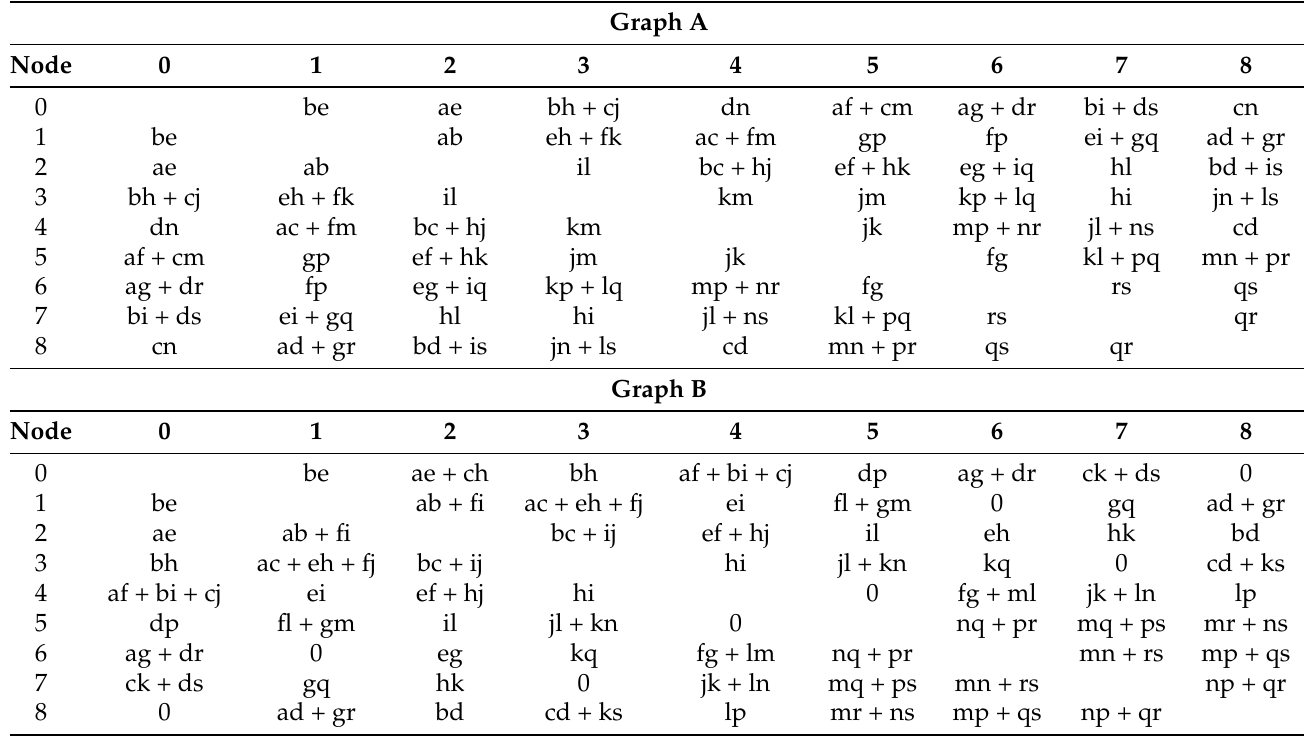
Table 1. Minimal length path consisting of two edges.